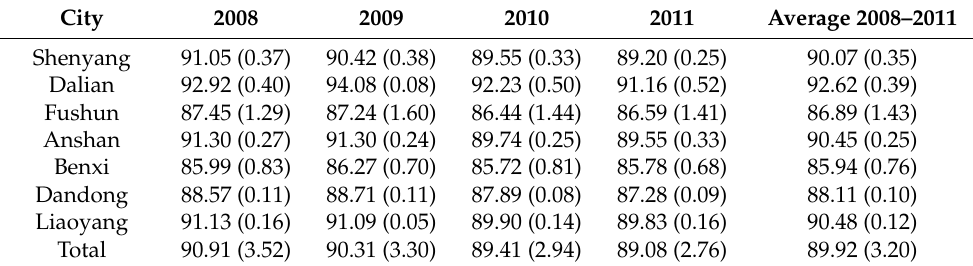
Table 2. O 3 concentrations for 94 schools in northeastern China,